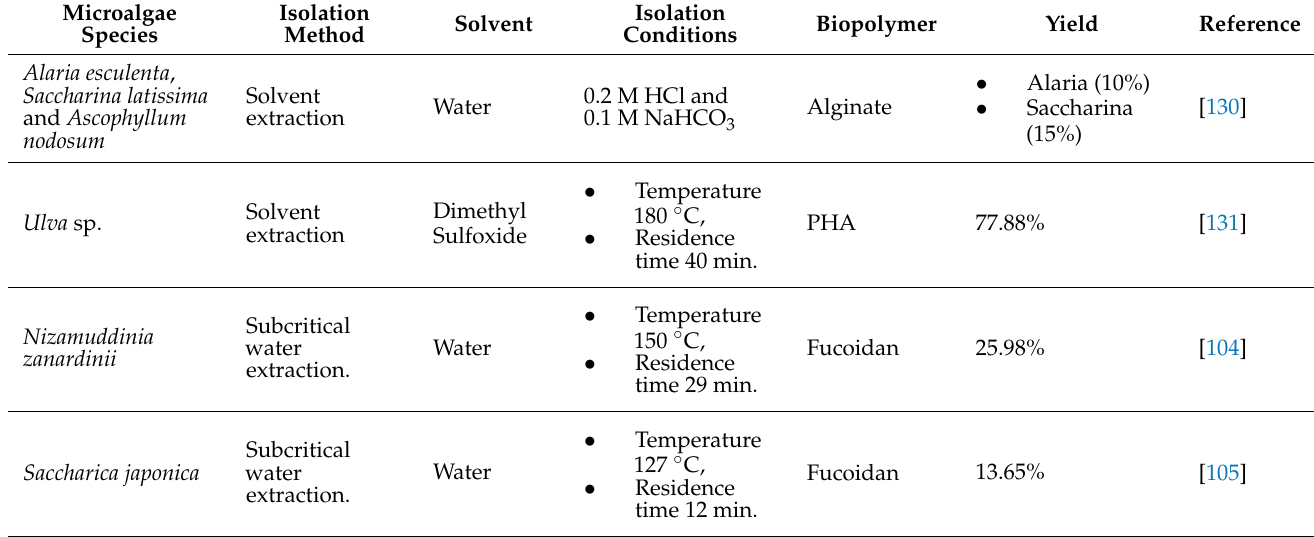
Table 2. Isolation techniques for biopolymer extraction from